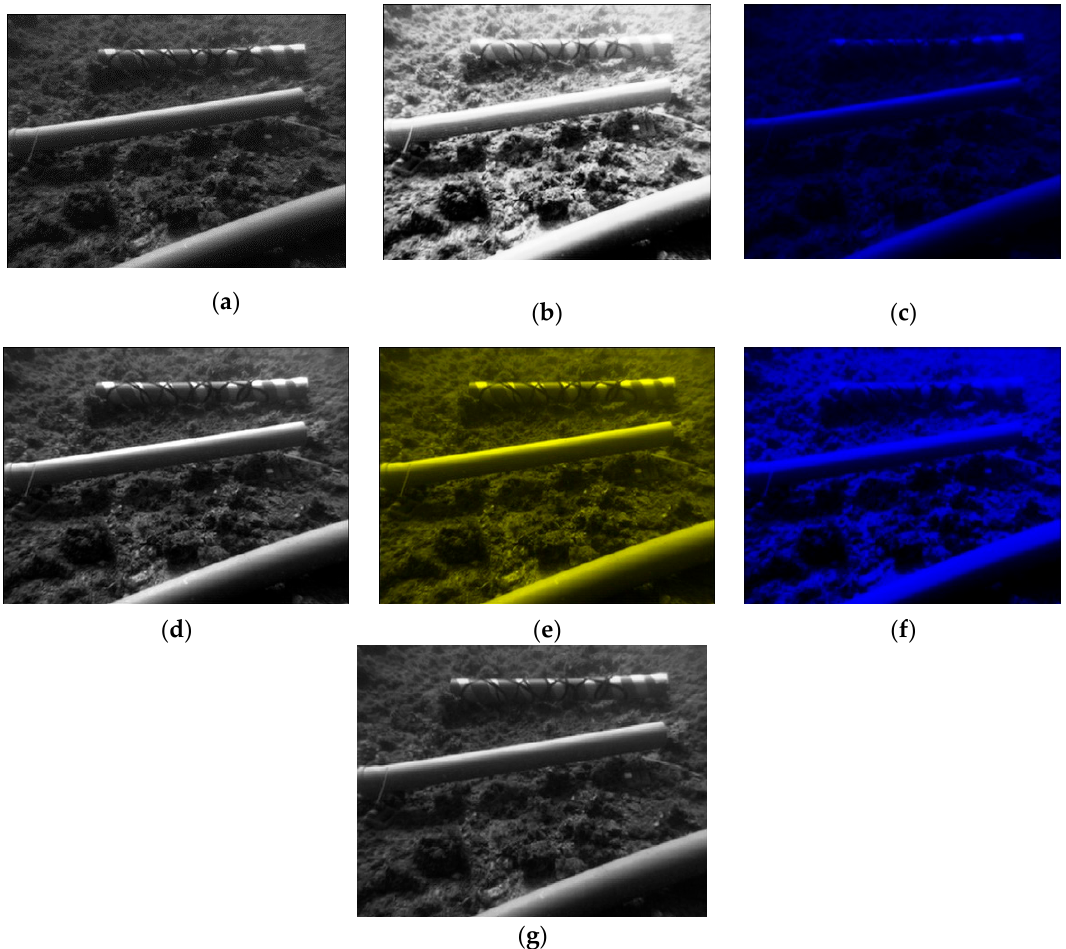
Figure 4. Comparison on results of several image enhancement methods. ( a ) Original Image ( b ) Histogram Equalization [41]; ( c ) Integrated Color Model [42]; ( d ) Relative Global Histogram Stretching [19]; ( e )UnsupervisedColorCorrectionMethod[43]; ( f )RayleighDistribution[44]and( g ) Screened Poisson.